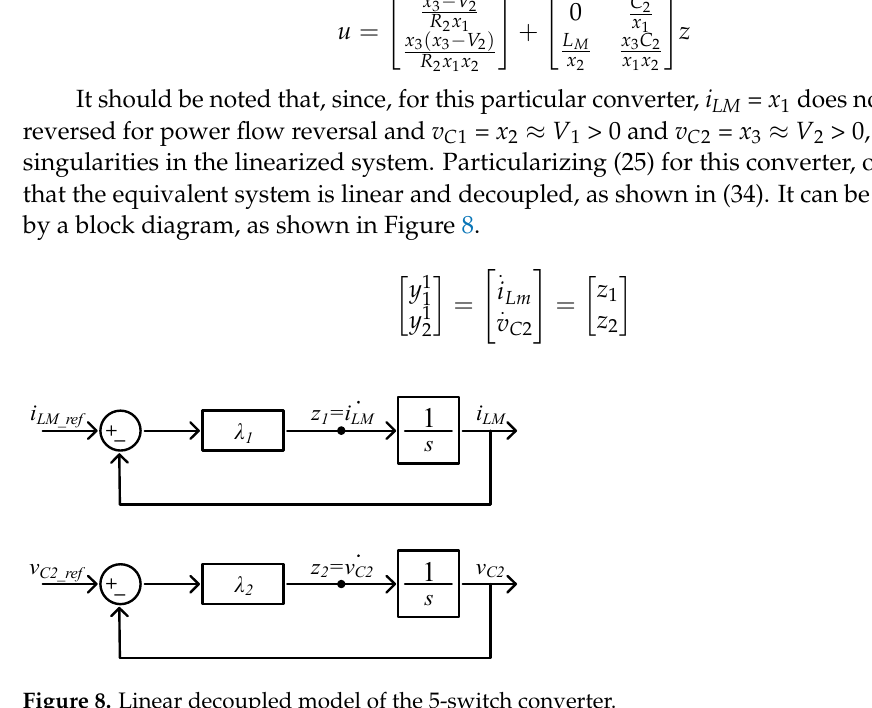
Figure 8. Linear decoupled model of the 5-switch converter.